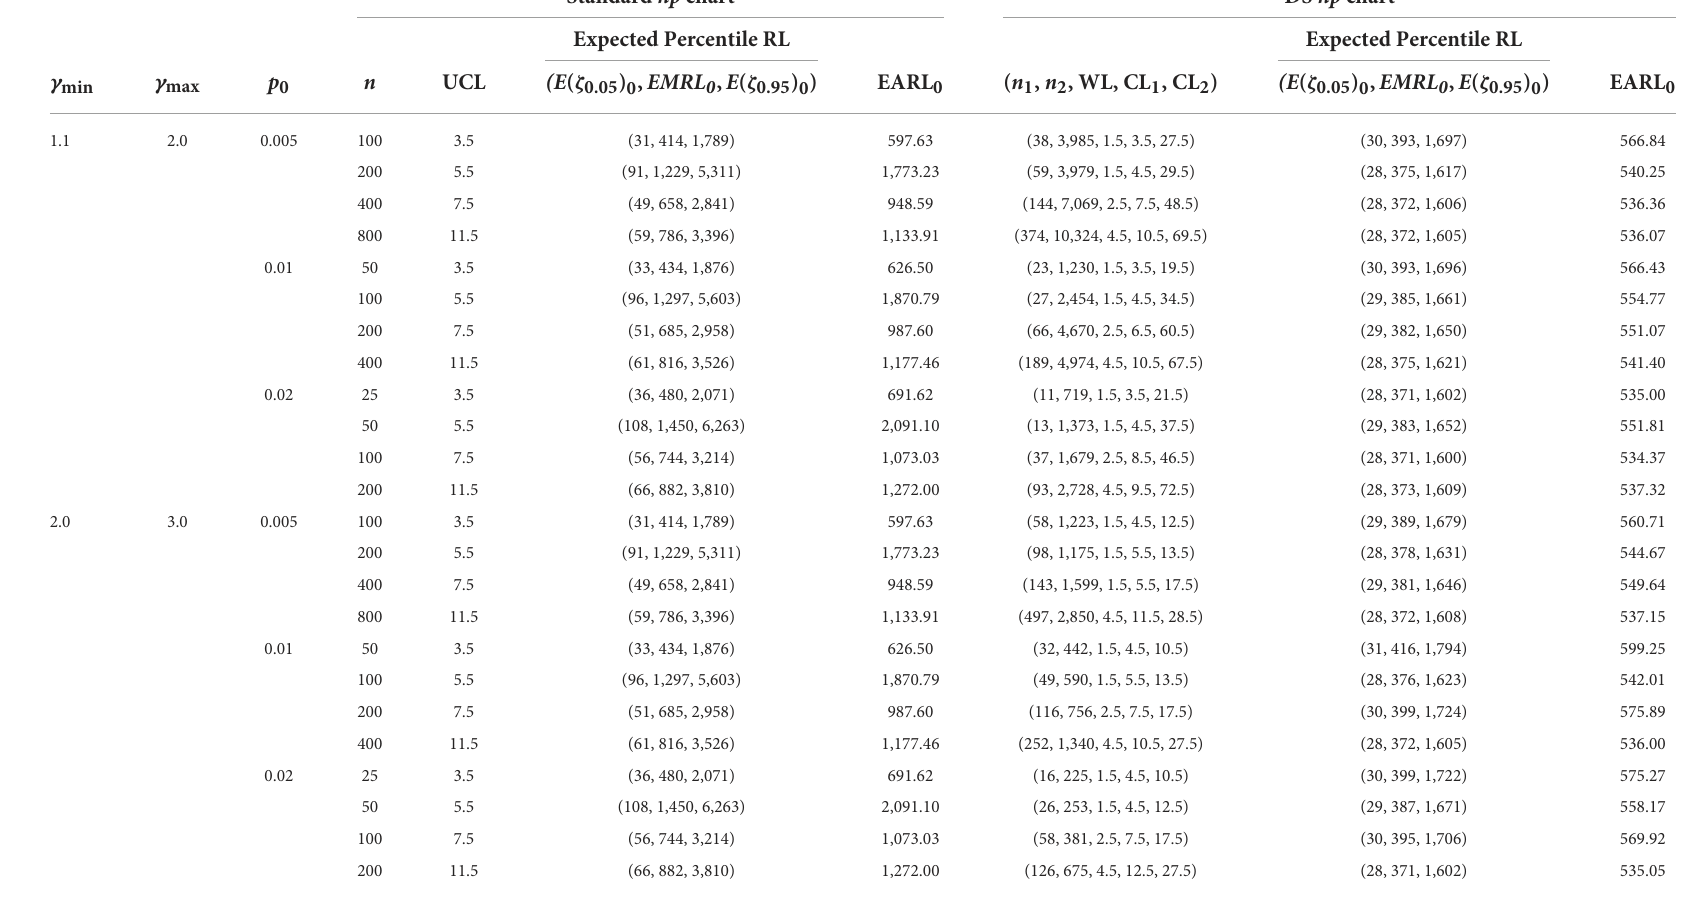
TABLE 2 Charting parameters with corresponding and EARL 0 for standard np and optimal DS np charts, when MRL 0min = 370.4. Standard np chart DS np